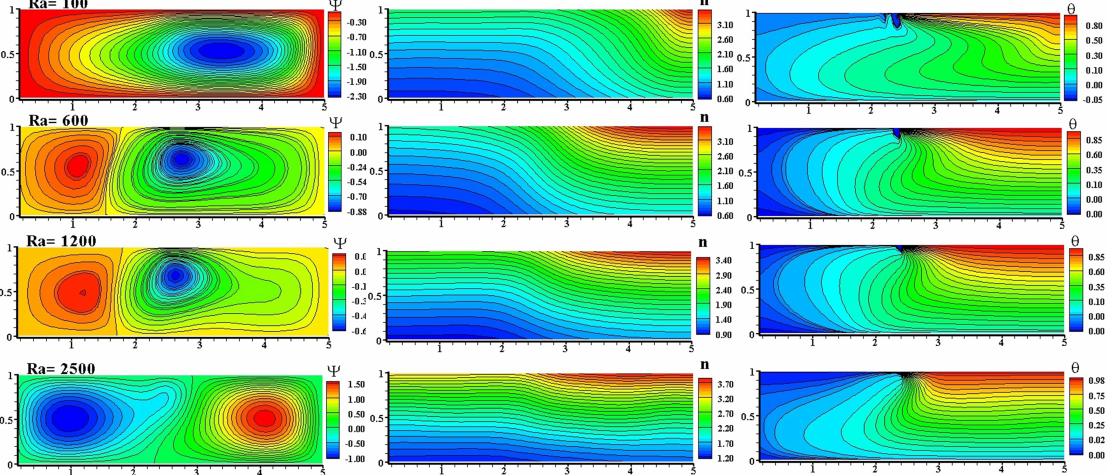
Figure 6. Case 4. From left to right, streamlines, microorganisms concentration and dimensionless temperature contours. For Sc = 1, Pe = 1, Ra T = 1708 and bioconvective Ra for 100, 600, 1200 and